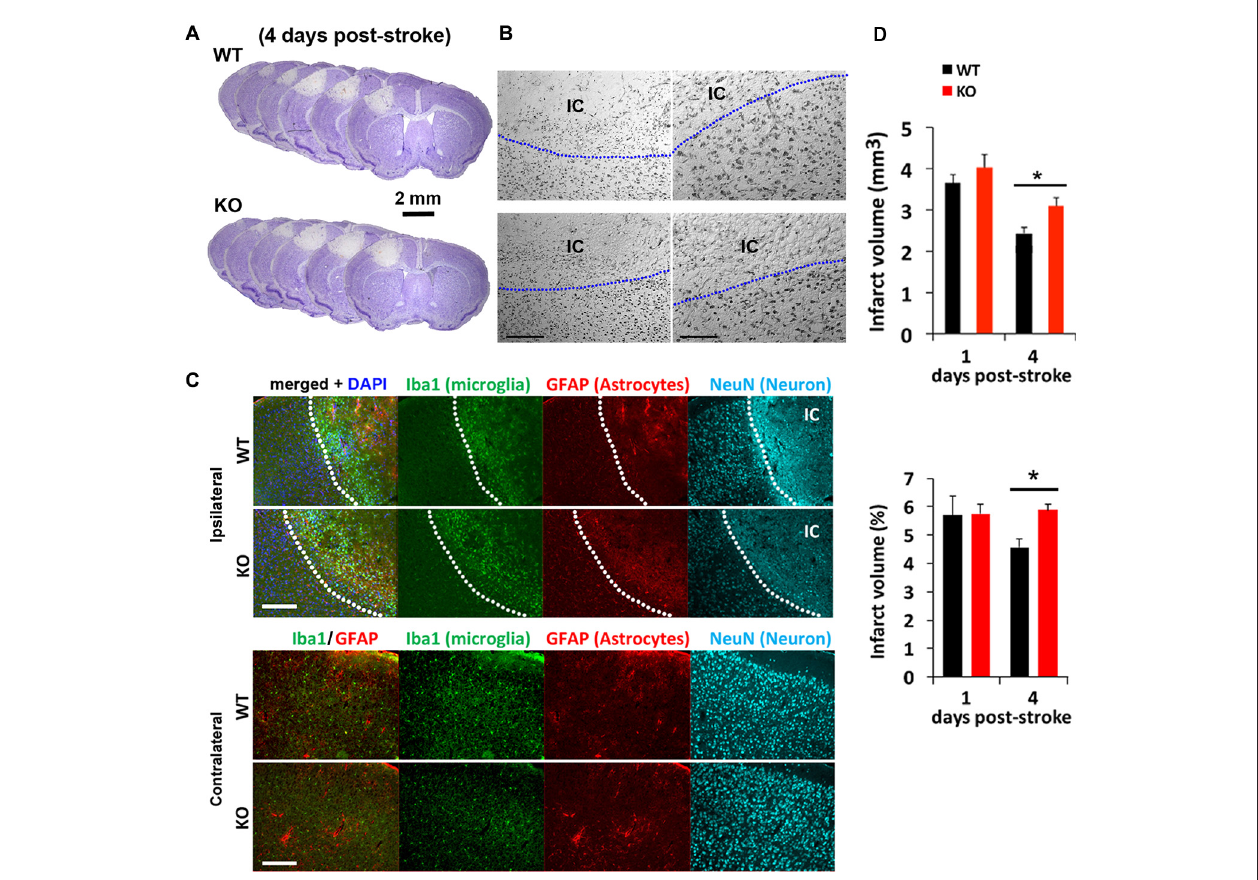
FIGURE 2 | Photothrombosis induced focal ischemic injury to the sensorimotor cortex persists in IRF2BP2KO mice at 4 days. (A) Cresyl violet staining reveals lesion area where neurons are lost and devoid of stain. Representative brain sections from IRF2BP2KO (KO) and littermate control mice (WT) 4 days after photothrombosis-induced stroke injury. (B) High power magnification showing the clear demarcation of the ischemic core (IC). Left scale bar, 200 µ m; right scale bar, 100 µ m. (C) Immunofluorescence labeling of Iba+ microglia recruited to the IC and activation of astrocytes revealed by glial fibrillary acidic protein (GFAP). Neurons (NeuN+) are absent in the IC. Scale bar, 200 µ m. The corresponding region of the contralateral (non-ischemic) side, with few Iba1+ microglia, is shown for comparison. (D) Lesion regression is delayed in KO mice. N = 10–15 mice/group. ∗ p <